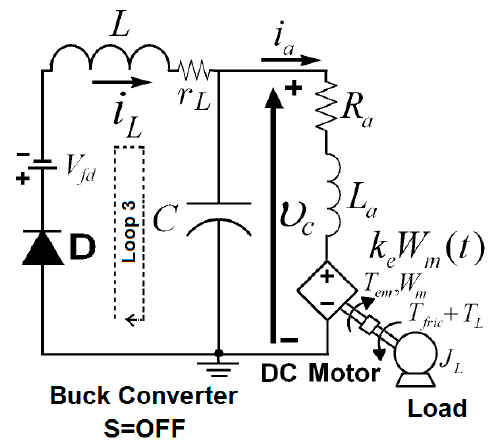
Figure 4. Electromechanical system with the switch OFF.